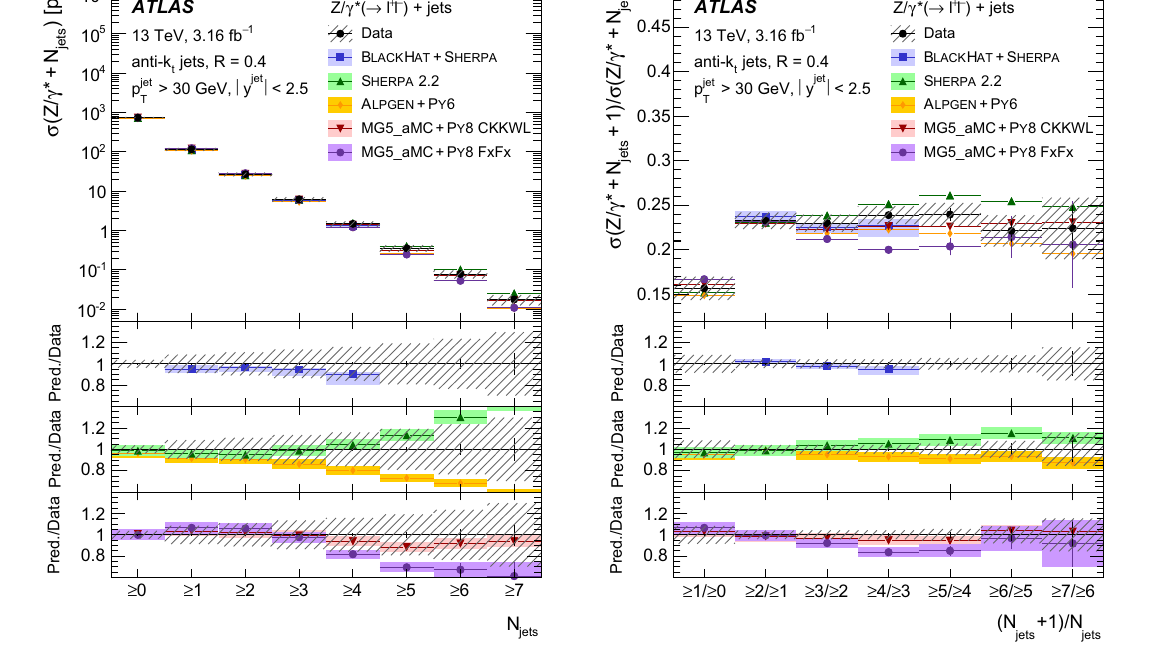
the data statistical and systematic uncertainties (including luminos- ity) added in quadrature. A constant 5% theoretical uncertainty is used for Sherpa 2.2 , Alpgen+Py6 , MG5_aMC+ Py8 CKKWL, and MG5_aMC+ Py8 FxFx.Uncertaintiesfromthepartondistributionfunc- tions and QCD scale variations are included in the BlackHat+Sherpa predictions, as described in Sect.